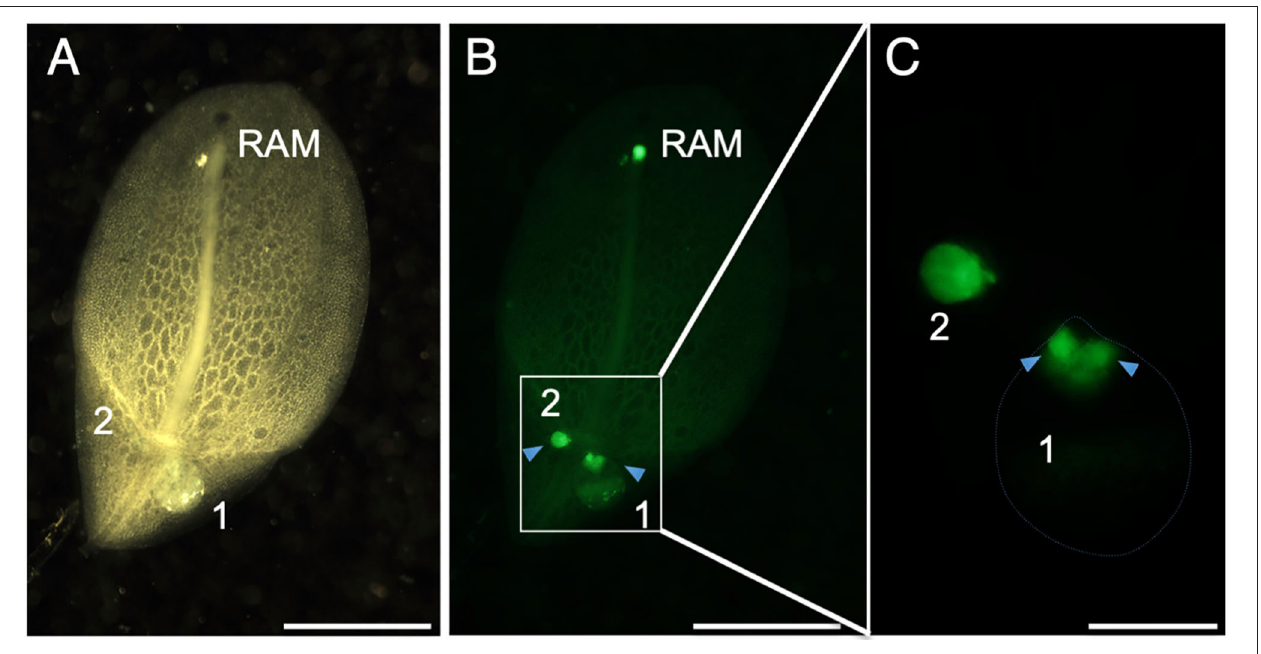
FIGURE 3 | EdU. (A) The abaxial side of a frond stained with ethynyl deoxyuridine (EdU). (B) Areas of EdU fluorescence (green) are visible at the RAM and the proximal region of the frond. Arrowheads indicate separate fluorescent regions from each of the two daughter fronds (1 and 2). (C) A close-up view of the area enclosed by the rectangle in (B) . Arrowheads indicate separate fluorescent regions in daughter frond 1. Scale bars: 2mm (A,B) and 0.5mm (C)